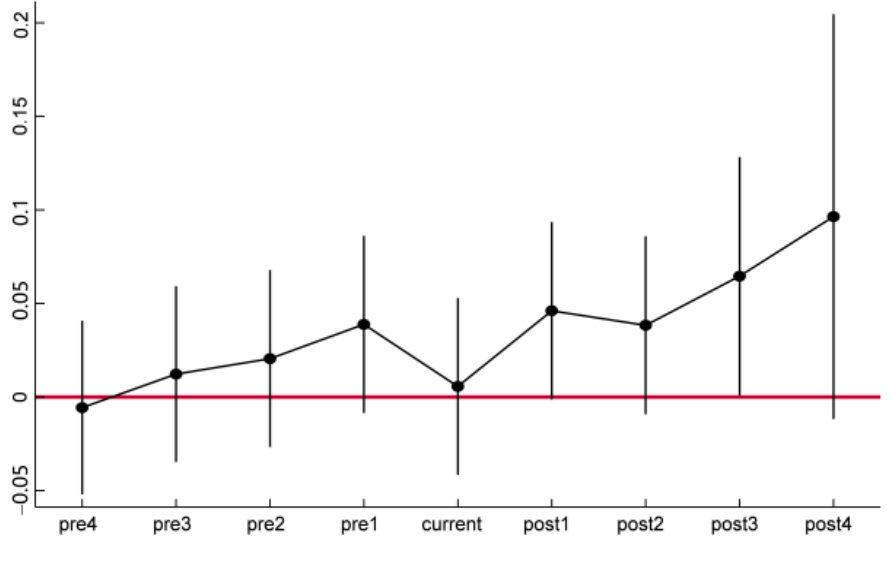
Figure 2. Parallel trend test